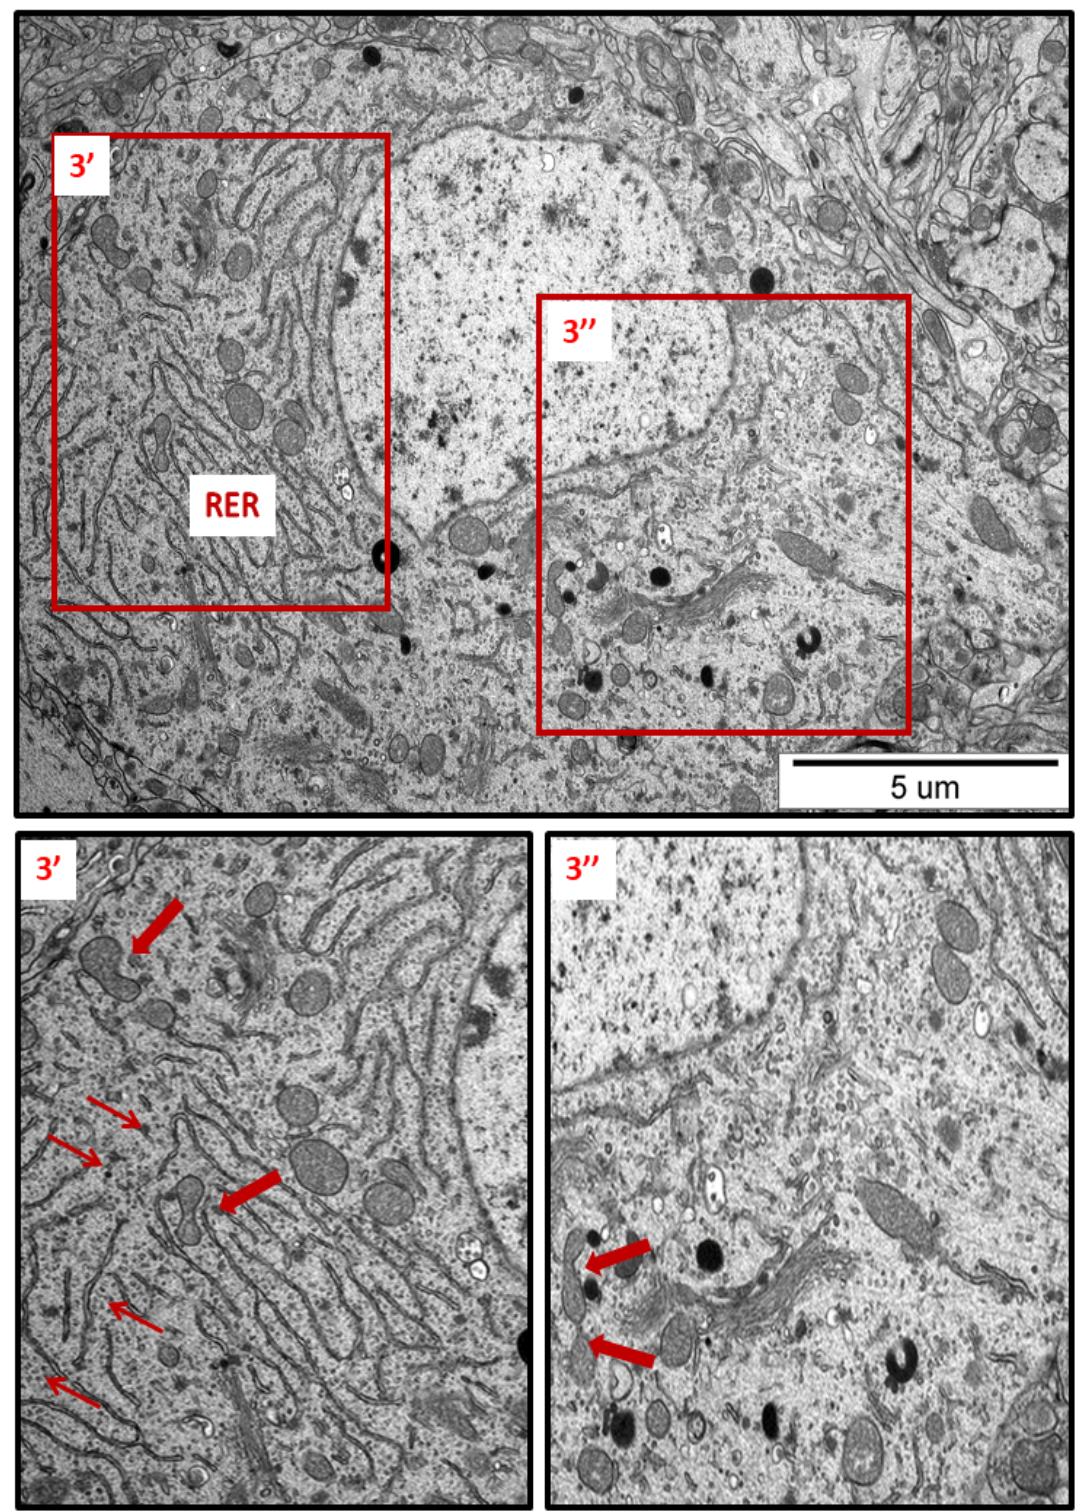
Figure 3. Representative TEM micrograph from hippocampal sections of AgNP-exposed animals. An overview of neuronal cytoplasm with enlarged and thickened rough endoplasmic reticulum (RER) cisternae; detached ribosomes (thin arrows); fragmentation of mitochondria (arrows); lysosomes (dark organelles in inset 3 ″ ). Insets (3 ′ , 3 ″ ) were magnified 2–3×. Images are typical for each of the 3 examined animals per group.